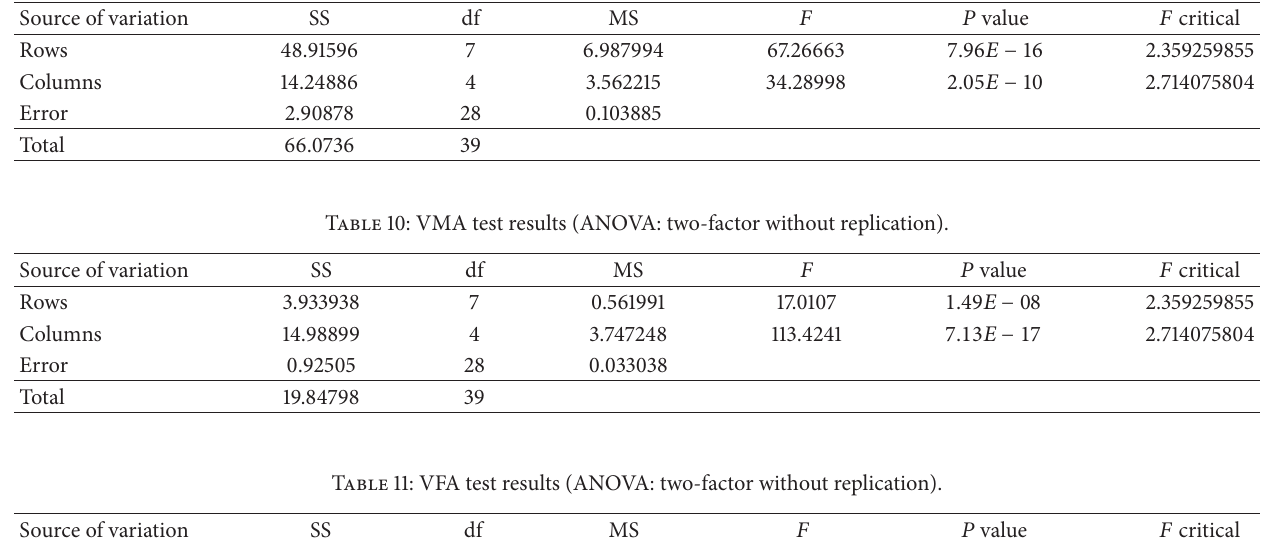
Table 9: VTM test results (ANOVA: two-factor without replication).